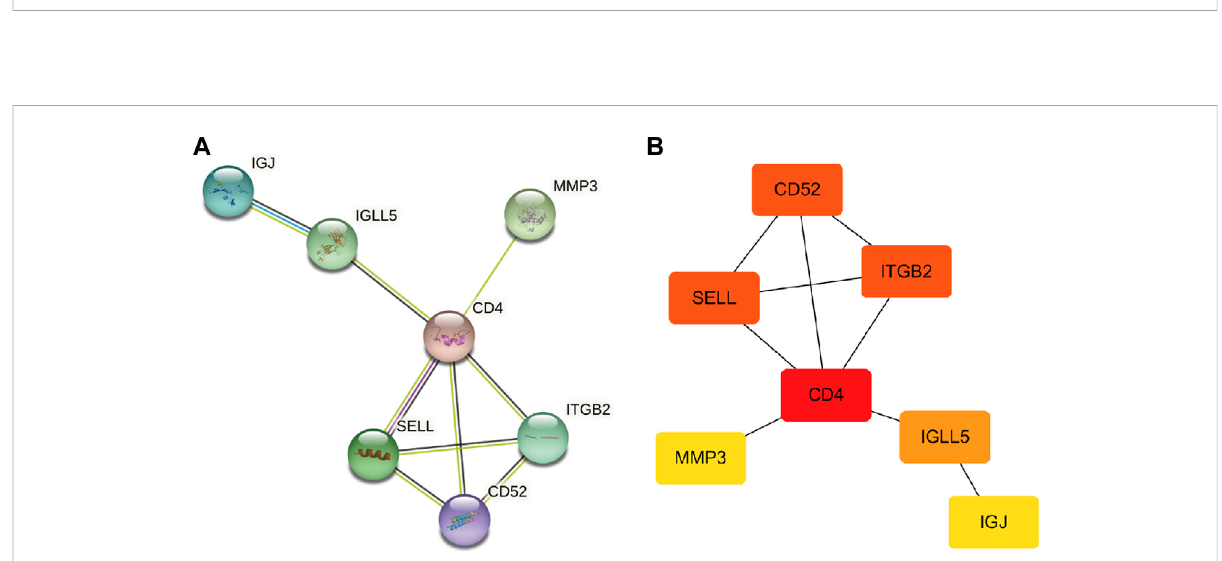
FIGURE 4 PPI network. (A) PPI network of overlapping hub genes. (B) Most signi fi cant upregulated genes were obtained (the deeper the color, the higher the